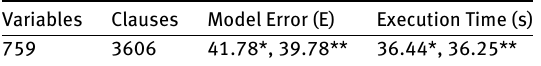
Table 3: Cumulative error in model learning (* = with MaxWalkSat, ** = with MaxSatSolver).